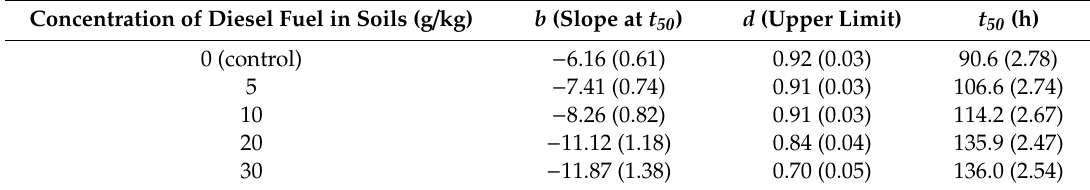
Table 1. Parameter estimates of the log-logistic model obtained by fitting the event-time model. (Values in parentheses indicate standard errors).